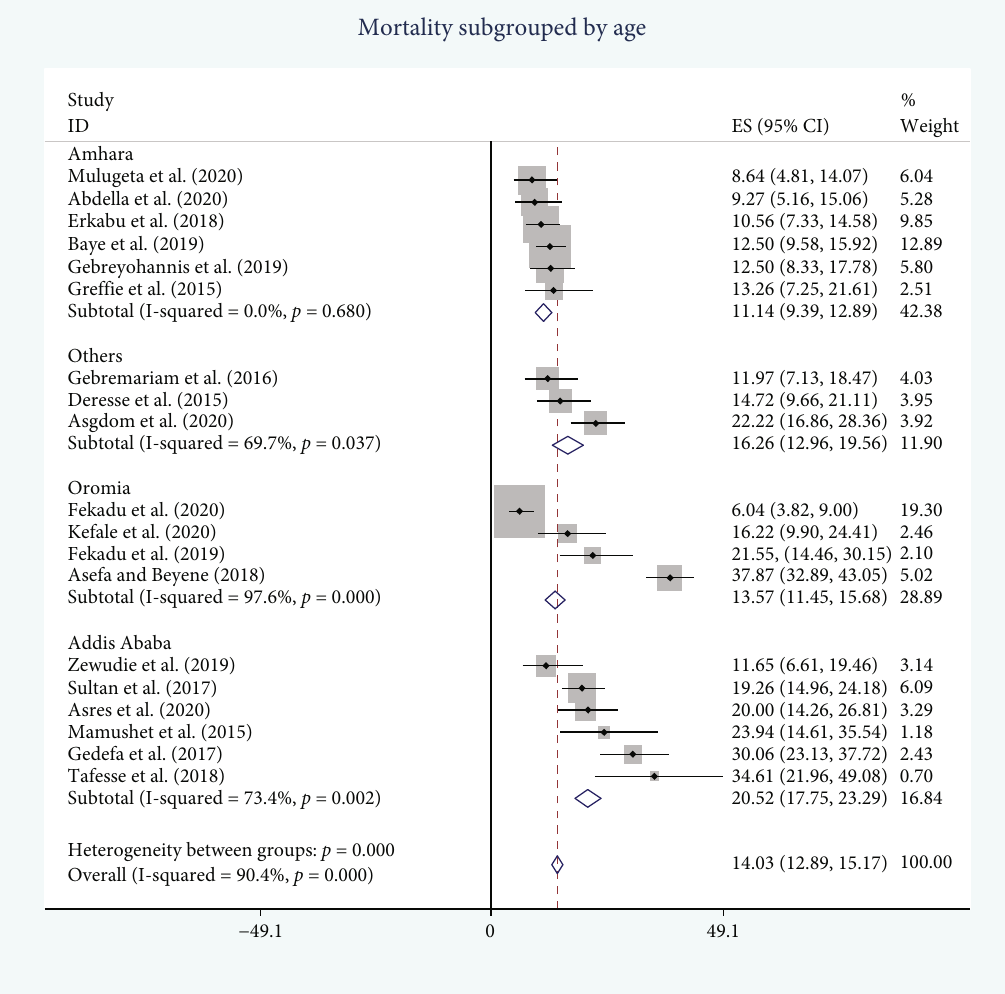
Figure 3: Forest plot of pooled in-hospital stroke mortality subgrouped by geographical